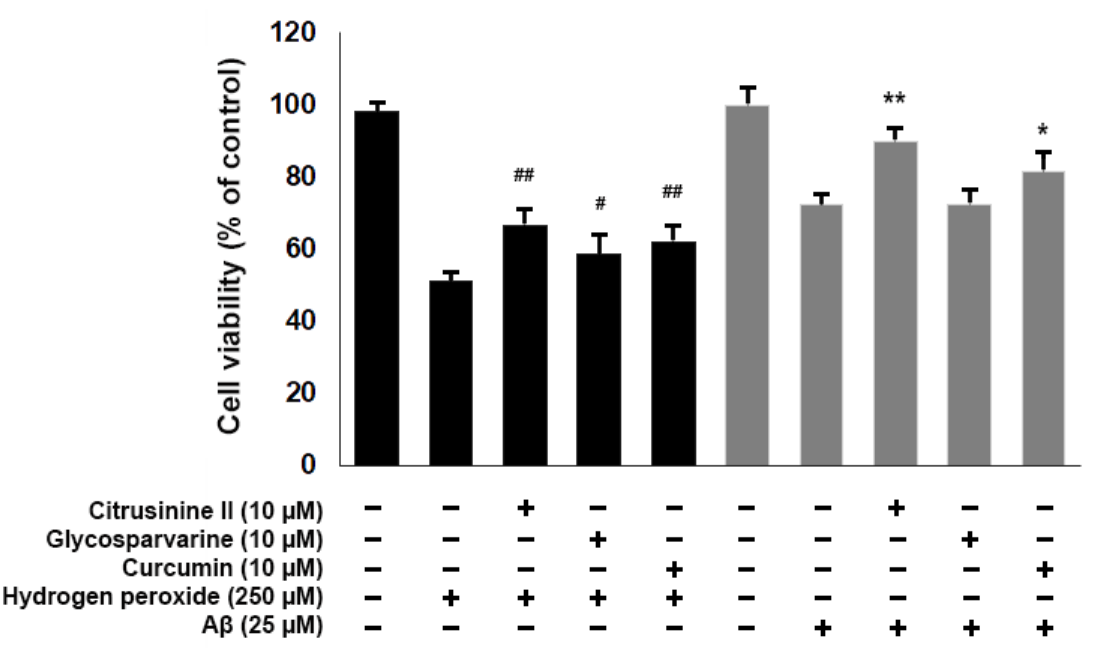
Figure 8. Effects of citrusinine II and glycosparvarine on H 2 O 2 and A β 1–42 induced cell death in SH-SY5Y cells. Curcumin at 10 µ M was used as a reference standard. The values are reported as mean ± SD ( n = 4). One-way ANOVA followed by the Tukey test, # p < 0.05, ## p < 0.01 versus H 2 O 2 treated group, * p < 0.05, ** p < 0.01 versus A β 1–42 treated